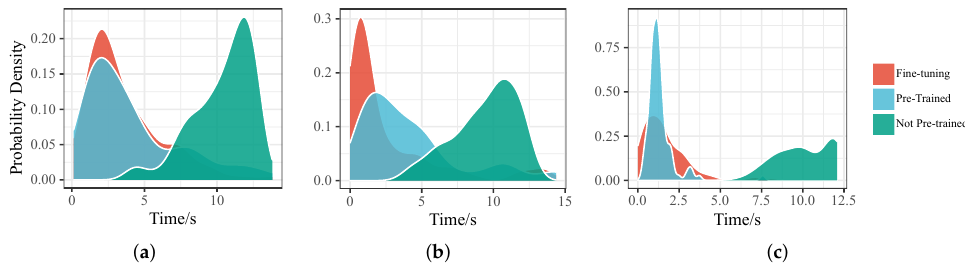
Figure 11. The probability density function for computation time when small changes occur to the network. ( a ) PDF for computation time when location of users changes. ( b ) PDF for computation time when E changes. ( c ) PDF for computation time when |V s | changes.